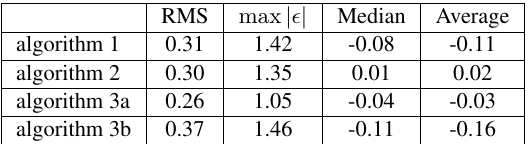
Table 3. Statistical values of the residuals to the manual